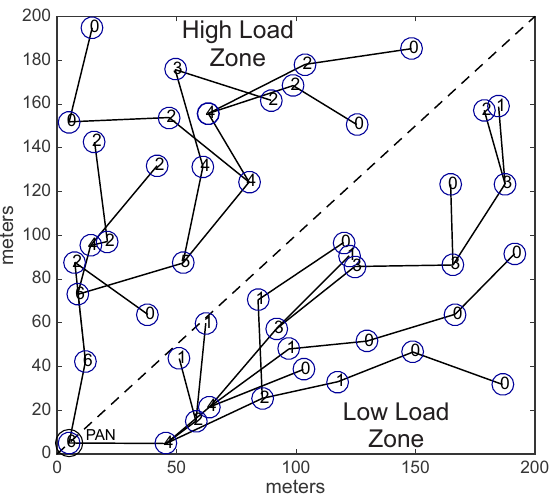
Figure 24. An example of Superframe Order configuration for all cluster-heads, using Load-SDA scheme (conditioned Scenario).